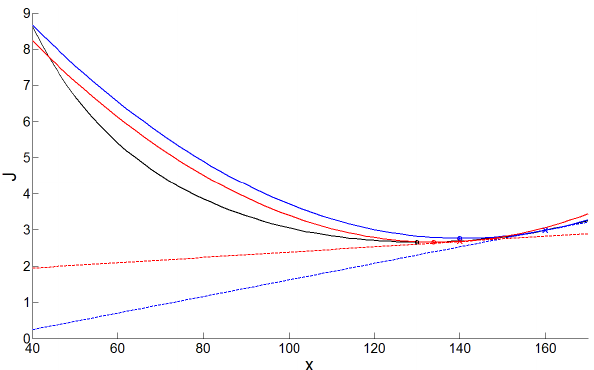
Fig. 3. Cost function J( x ) (black curve) for the October 2001 event (δ x ) (blue curve) for the and its incremental approximations J inc 1 Figure 3. Cost function J( x ) (black curve) for the October 2001 event and its incremental (δ x ) (red curve) for the second one. The first outer loop, and J inc 2 approximations J 1inc (  x ) (blue curve) for the first outer loop and J 2inc (  x ) (red curve) for the blue (respectively red) cross indicates the background x 1 = x b for second one. The blue (respectively red) cross indicates the background x 1 = x b for the first the first (respectively second) outer loop, and the circles indicate the minima of the functions. The dashed lines represent the tangent (respectively second) outer loop and the circles indicate the minima of the functions. The of the incremental approximations in blue for the first outer loop dashed lines represent the tangent of the incremental approximations in blue for the first outer and in red for the second loop and in red for the second one.